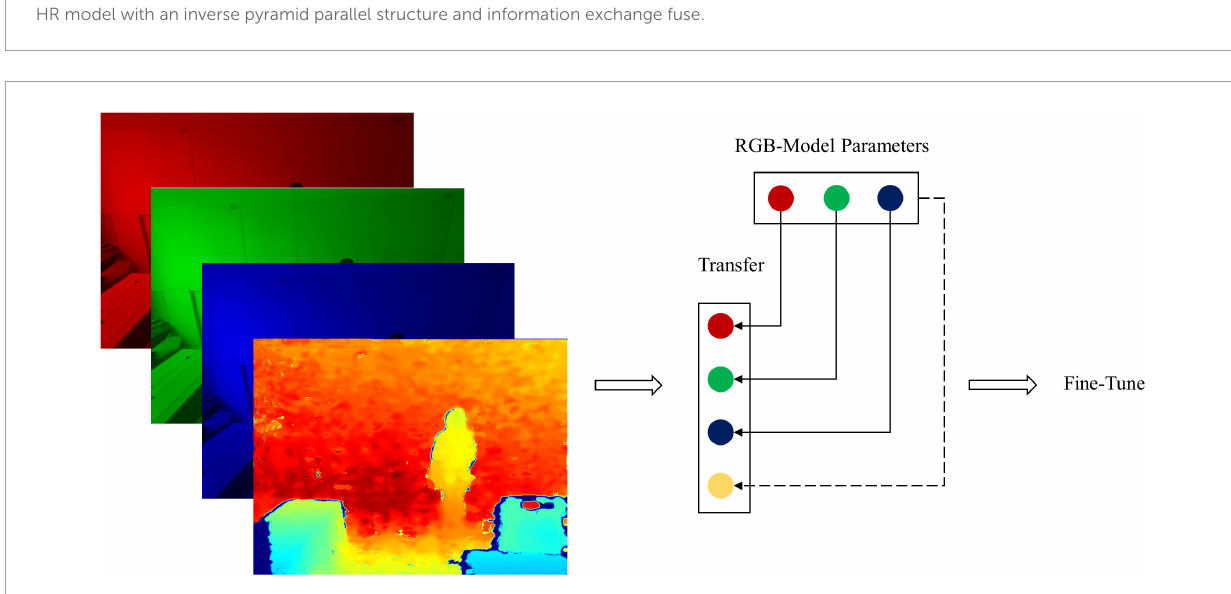
FIGURE4 The RGB-D model transfer based on the RGB